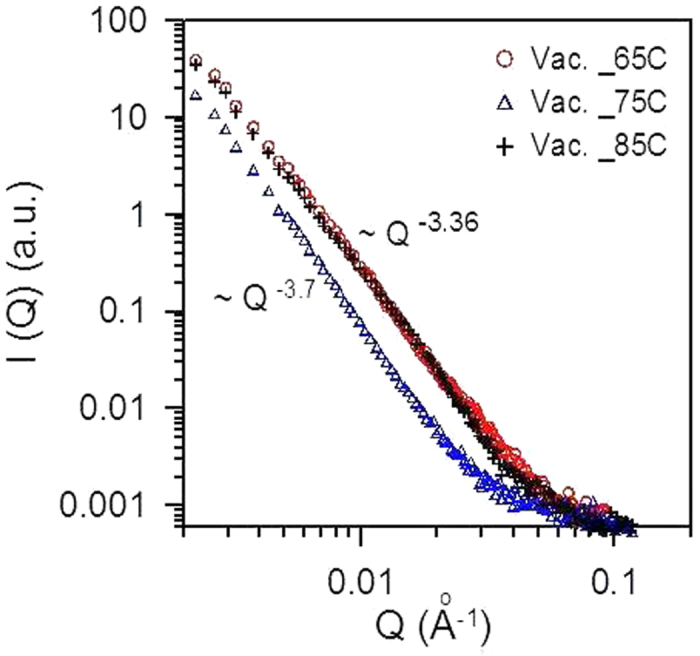
GISAXS profiles of the vacuum-deposited CH3NH3PbI3−xClx films prepared at the substrate temperatures of 65, 75 and 85 °C, respectively.